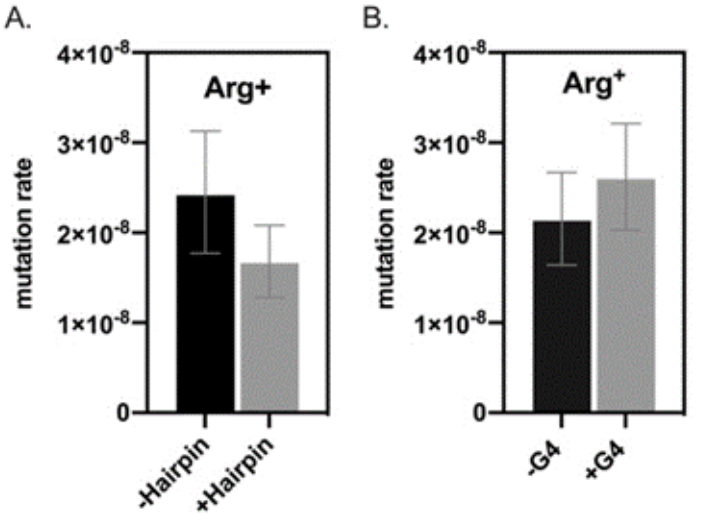
Figure 4. Hairpin ( A ) and G4 DNA ( B ) forming motifs did not affect mutation rates in growing B. subtilis cells. Bars represent mutation rates using the MSS maximum likelihood method, and error bars are confidence limits (CL 95 ) .